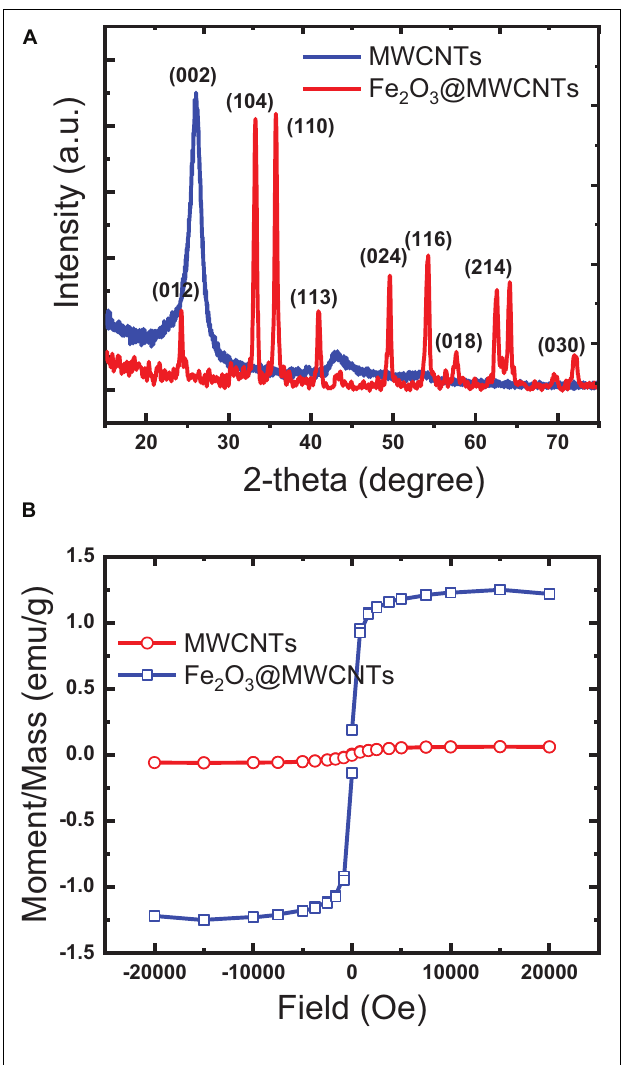
FIGURE 3 | Characteristics of the papered pristine MWCNTs and Fe 2 O 3 @MWCNTs: (A) X-ray diffraction; (B) magnetism. FIGURE 4 | FTIR spectra of the MWCNTs and Fe 2 O 3 @MWCNTs before and after interaction with IVR. (A) 4000–2000 cm − 1 ; (B) 2000–400 cm − 1